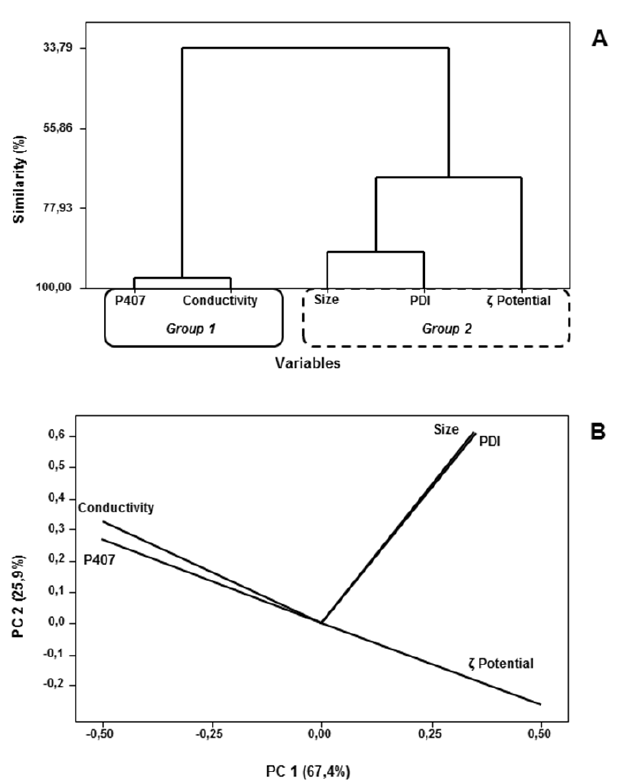
FIGURE 6 - HCA and PCA analyses of samples without GF - (A) dendrogram of the P407 samples using the single linkage method and Mahalanobis distance; (B) Loading plots (PC1 versus PC2) from variables. Group 1: P407 (polymer concentration) and conductivity; Group 2: particle size, PDI (polydispersity index), and ζ potential.